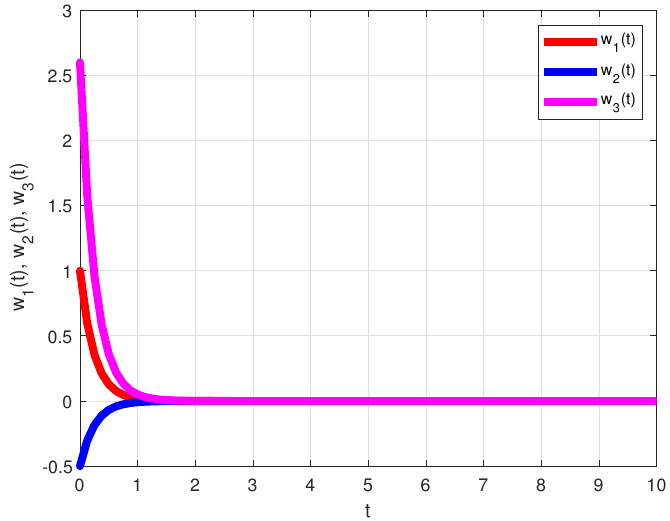
Figure 6. The time responses of the states w 1 ( t ) , w 2 ( t ) and w 3 ( t ) of system (70) for the external inputs y ( t ) = [ 0,0,0 ] T in Example